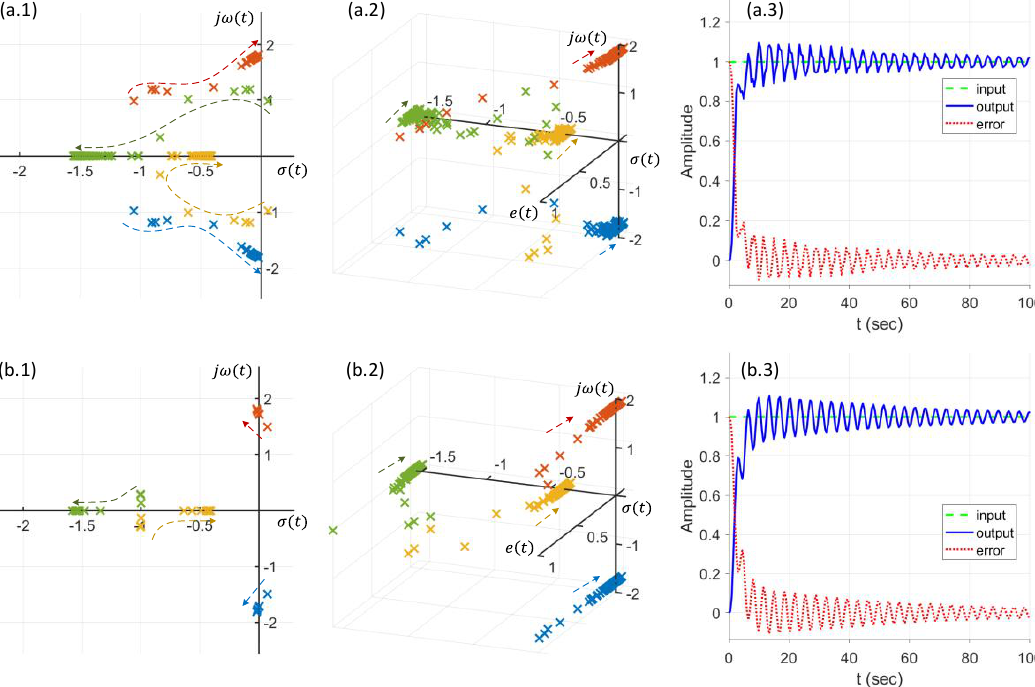
Figure 12. Dynamic pole motions of the controlled hybrid soft leg and the controlled system response by error change with the gains of ( a ) K pf = 1.1, K vf = 0.3, α = 1, and β = 20, and ( b ) K pf = 1.1, K vf = 0.3, α = 1, and β = 0.2. The system responses were slightly distinct with different oscillating shapes (higher β presented sharper peaks), but the rest of the response remained similar. The arrows indicate the direction of pole motions.